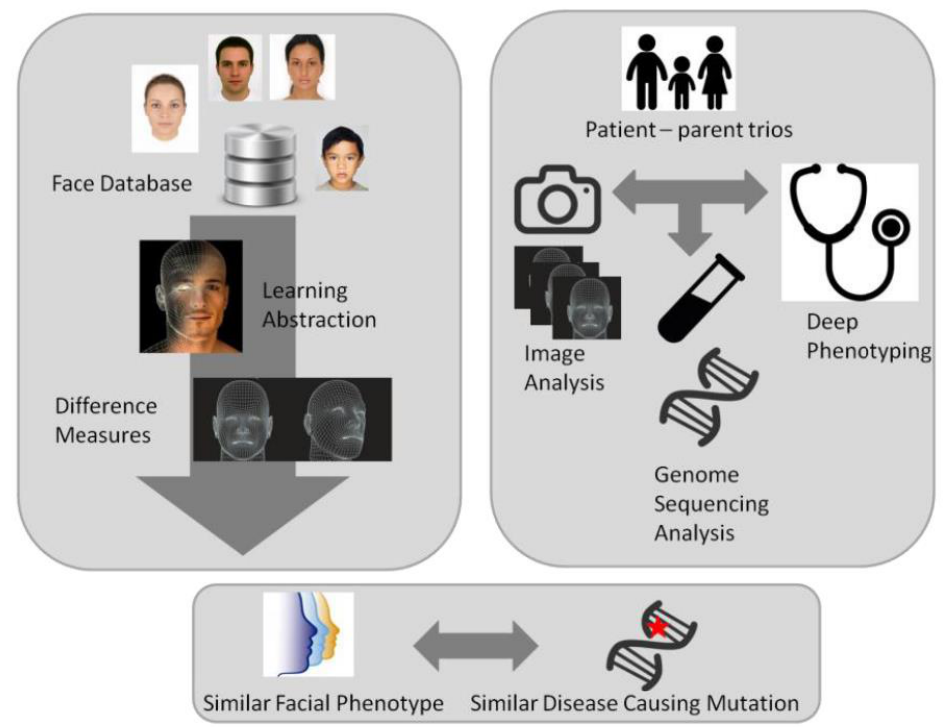
Figure 8. Novel strategy for characterizing novel gene mutations by combining the analysis of facial imaging algorithms with genomic data to establish a link between patients’ rare variants and potential facial gestalt.